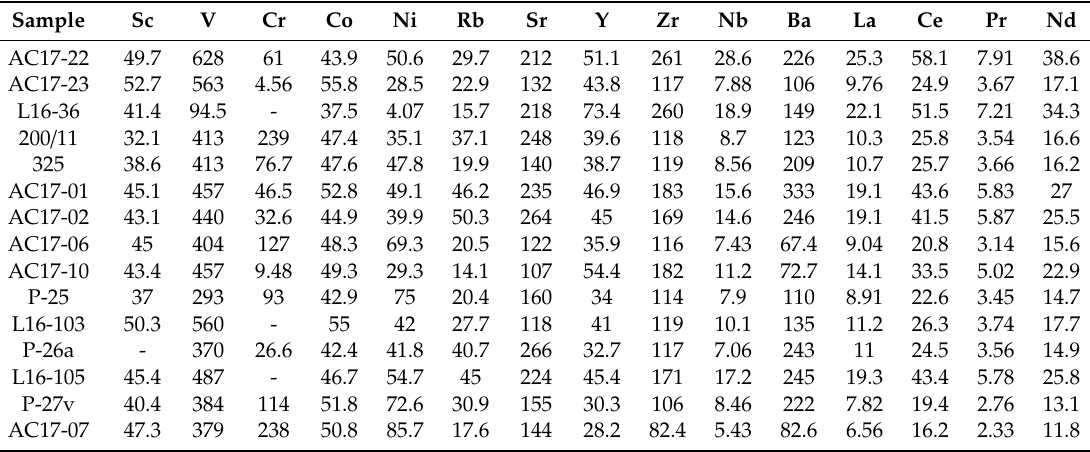
Table A3. The results of whole-Rock Major and Trace Element Measurements